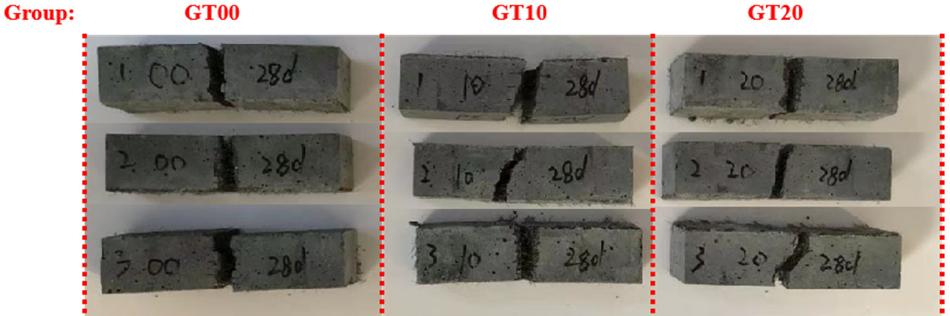
Figure 9. Specimens after flexural failure.